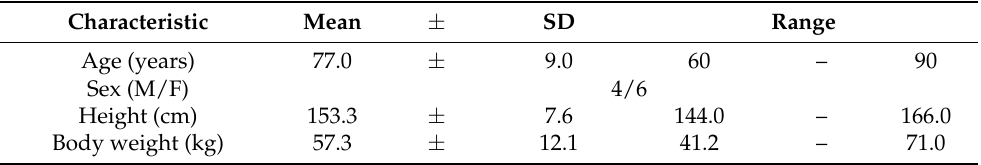
Table A1. Characteristics of participants in the preliminary evaluation of the reliability of plantarflex- ion angular velocity ( n = 10).